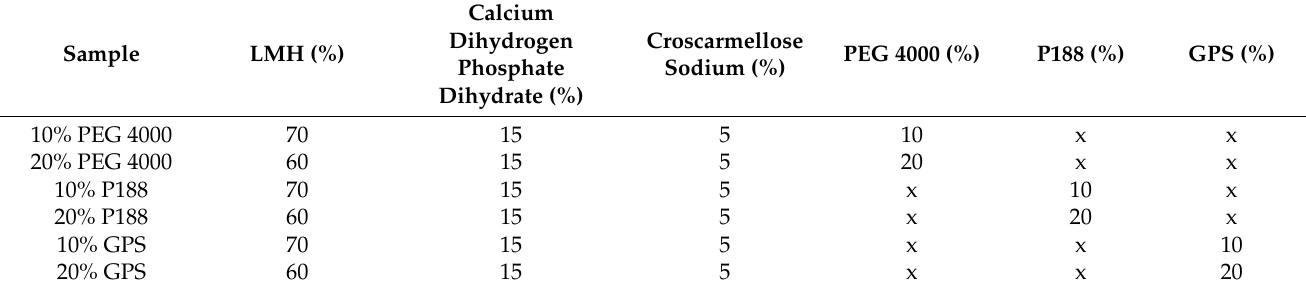
Table 1. Composition of the mixtures co-processed by fluid-bed melt